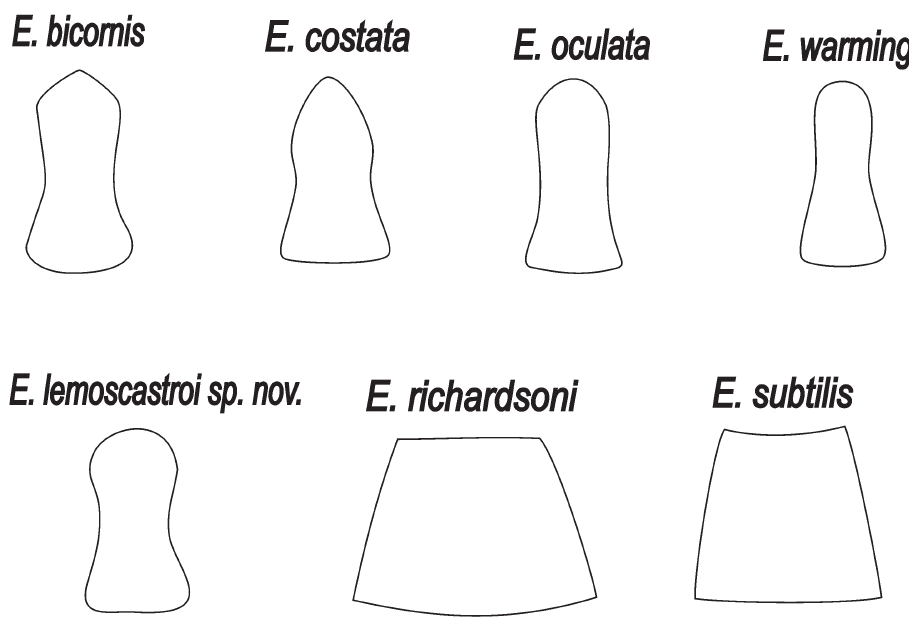
Figure 17. Morphological variation of the frontal lamina among the Brazilian species of the genus Excorallana